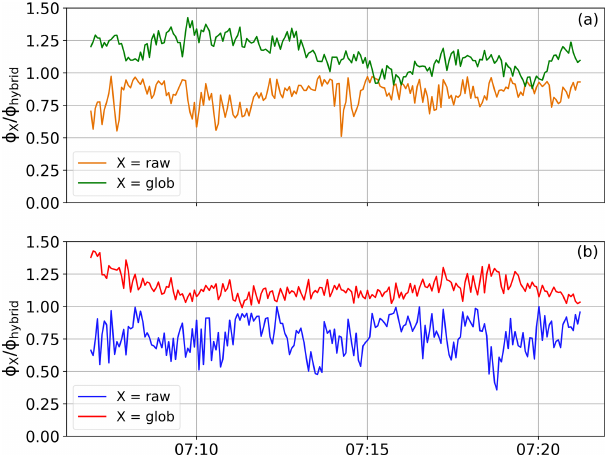
Figure 7. Relative deviations of retrieved SO 2 emission rates shown in Fig. 6 for the “young_plume” (a) and the “aged_plume” (b) PCS lines using the same colour codes as in Fig. 6. The ratios are plotted relative to the results of the proposed flow_hybrid method. Results based on the cross-correlation analysis tend to be slightly larger (by about + 14%), while the uncorrected OF velocities often yield un- derestimated SO 2 emission rates (up to